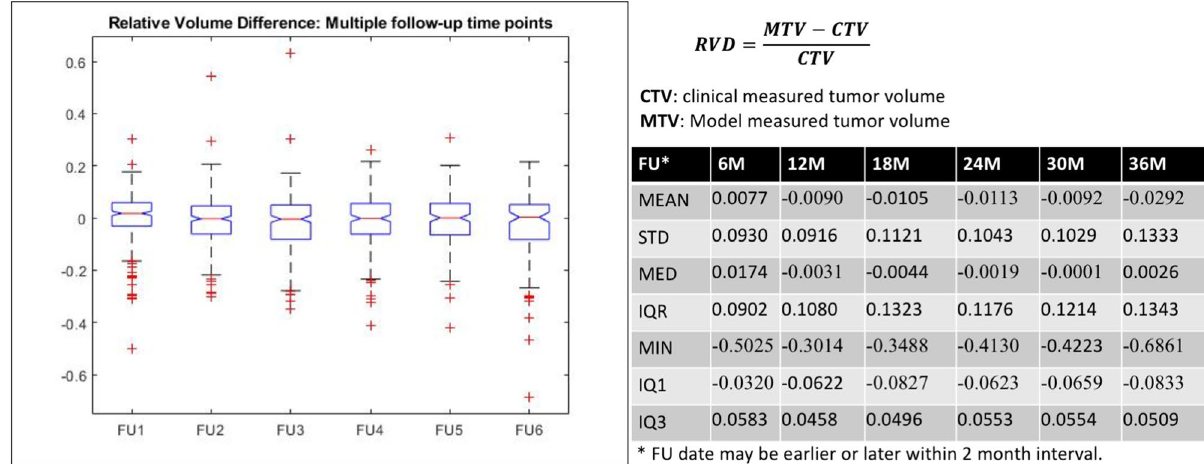
Figure 2. Longitudinal analysis of parametric MR images from 381 VS patients. Regardless of the state of the tumor (progressed, pseudo-progressed, or regressed), there were negligible differences between the predictions of the proposed AI model and clinical measurements obtained by expert radiologists. The median differences are presented here at each follow-up time point: + 1.74%, − 0.31%, − 0.44%, − 0.19%, − 0.01%, and + 0.26 (Mean: average, Std: standard deviation, MIN: minimum, IQ1: 25th interquartile, IQ3: 75th interquartile, MED: median, MAX: